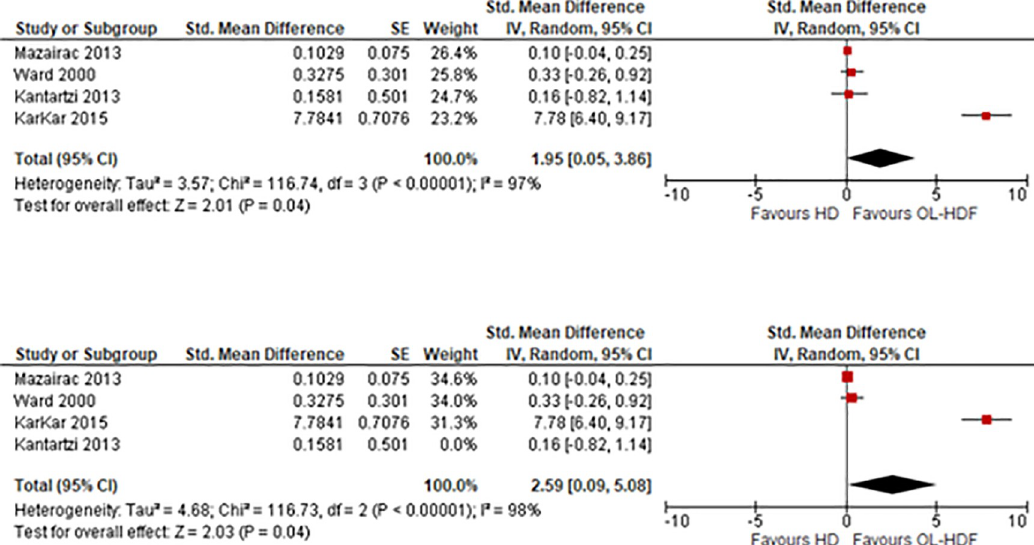
Fig 5. Fig 5–1. Meta-analysis of Social Activity, Fig 5–2. Sensitivity analysis of Social Activity.